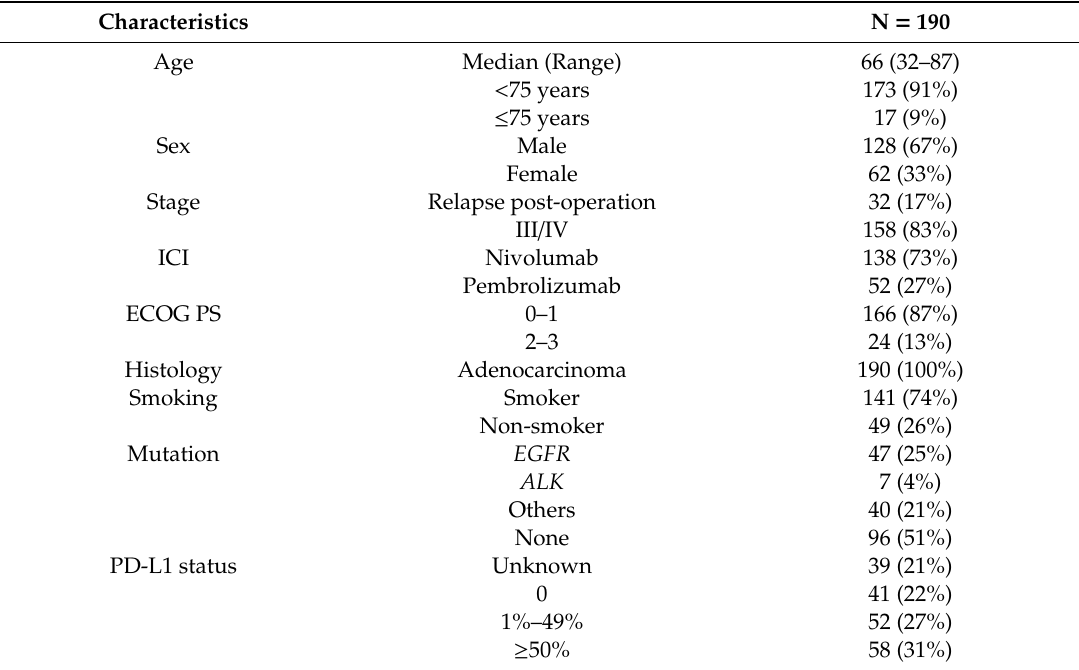
Table 1. Patient